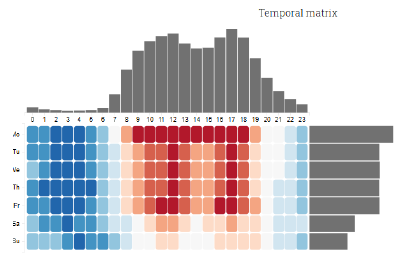
Figure 12. Temporal Matrix of Zone OMI E1.